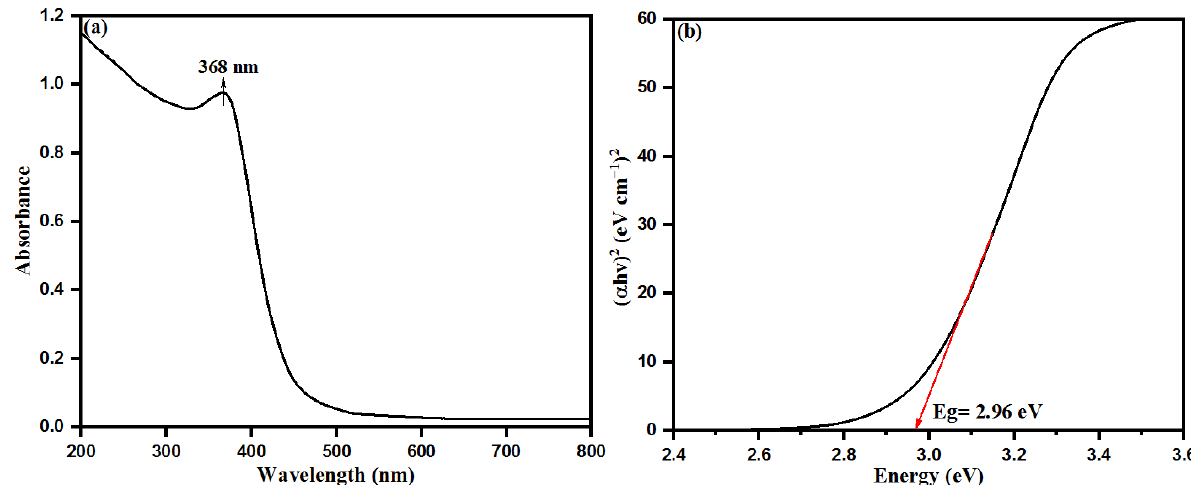
Figure 3. ( a ) UV − visible diffuse reflectance spectra and ( b ) Tauc plot for bandgap analysis of bio ‐ fabricated ZnONPs.